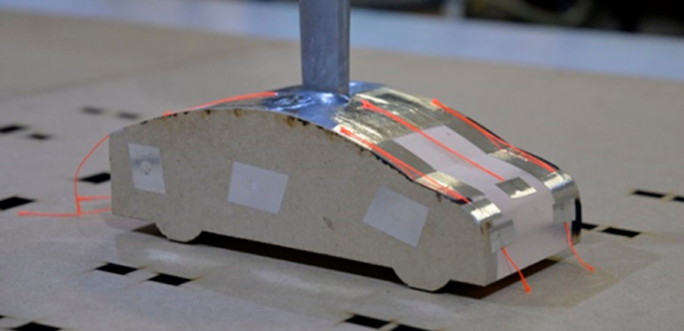
Figure 2. “Resnick” wind tunnel measurement model, after [50] © SAE International 2018.